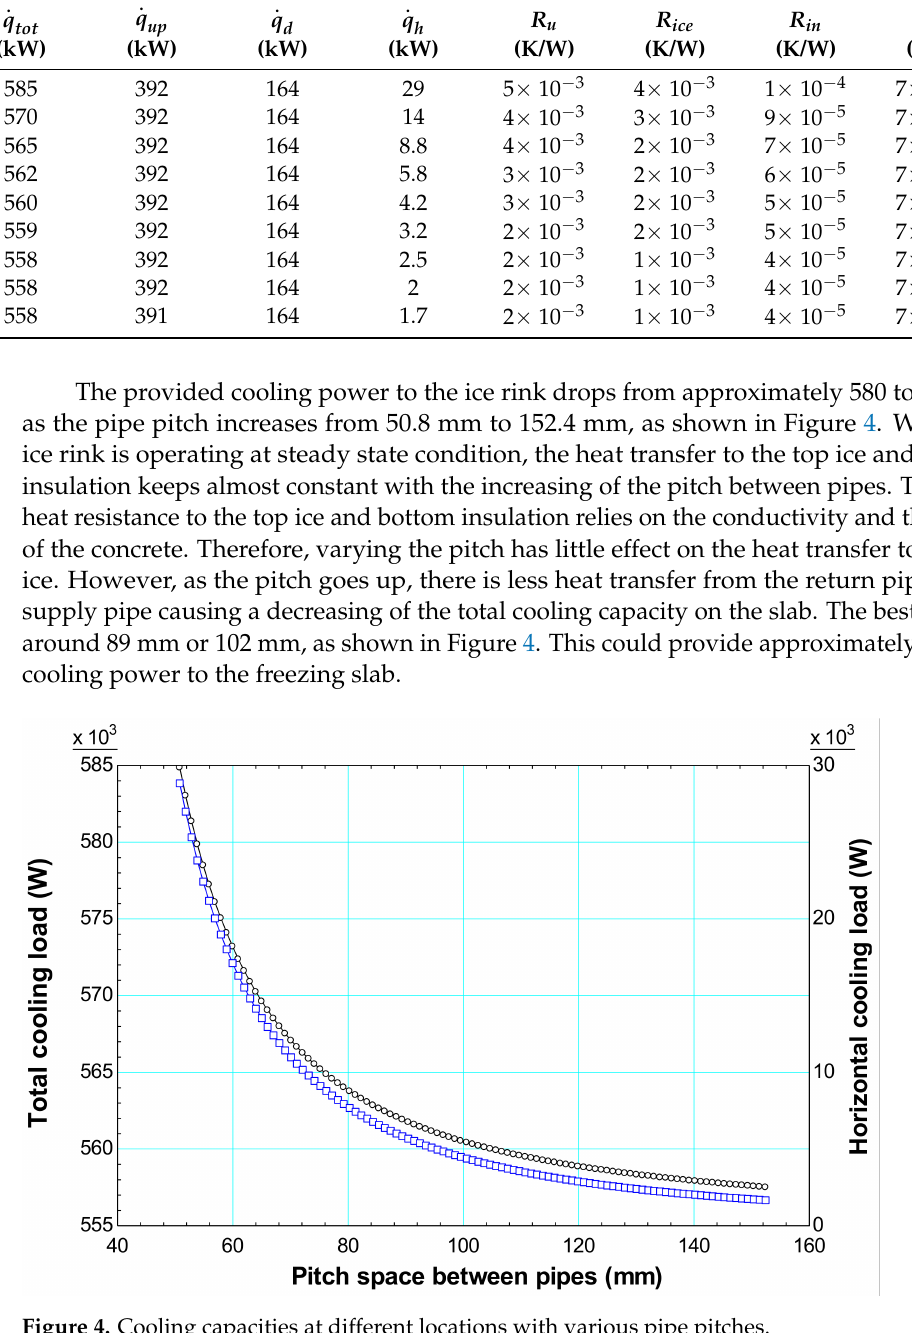
Figure 4. Cooling capacities at different locations with various pipe